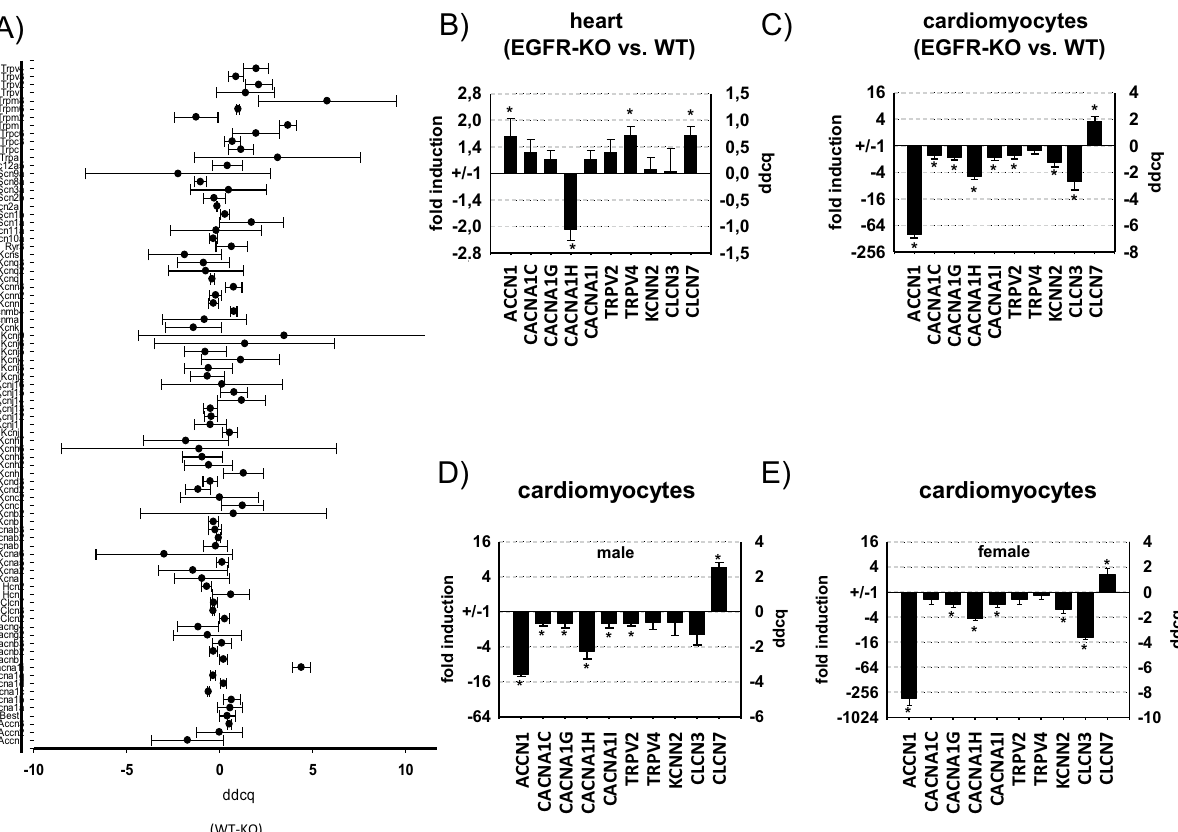
Figure 3. EGFR-dependent differential expression of ion channels in heart tissue and cardiomyocytes. ( A ) Detection of mRNA expression of 83 ion channels measured with qPCR arrays in heart tissue of EGFR-KO and WT mice and depicted as ΔΔCq values (ddcq) with confidence intervals (N = 2, n = 4; confidence interval of ΔΔct EGFR-KO vs. ΔΔct EGFR-WT ). ( B ) Validation of qPCR arrays by qPCR for the following ion channels: ACCN1 (amiloride-sensitive ion channel 1), CACNA1C, CACNA1G, CACNA1H, CACNA1I (voltage-dependent calcium channel subunit 1c/g/h/i/), TRPV2, TRPV4 (transient receptor potential cation channel, subfamily V, member 2/4), KCNN2 (small conductance calcium-activated potassium channel protein 2), CLCN3 AND CLCN7 (voltage-sensitive chloride channel 3/7) (N = 5–6, n = 10–12; data represented as mean ± SEM; * p ≤ 0.05). ( C ) Comparison of mRNA expression levels of different ion channels in freshly prepared cardiomyocytes of EGFR-KO and EGFR-WT mice (N = 10–11, n = 20–22; data represented as mean ± SEM; * p ≤ 0.05). ( D – E ) Comparison of ion channel expression measured by qPCR in freshly prepared cardiomyocytes of male EGFR-KO and WT mice ( D ) and female EGFR-KO and WT mice ( E ) (N = 4–6; n = 8–12; data represented as mean ± SEM; * p ≤